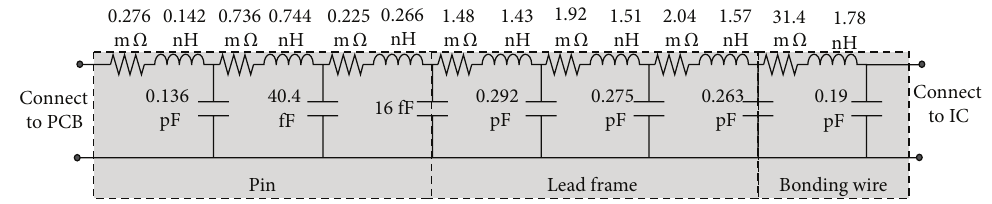
Figure 6: Equivalent circuit model of the package.